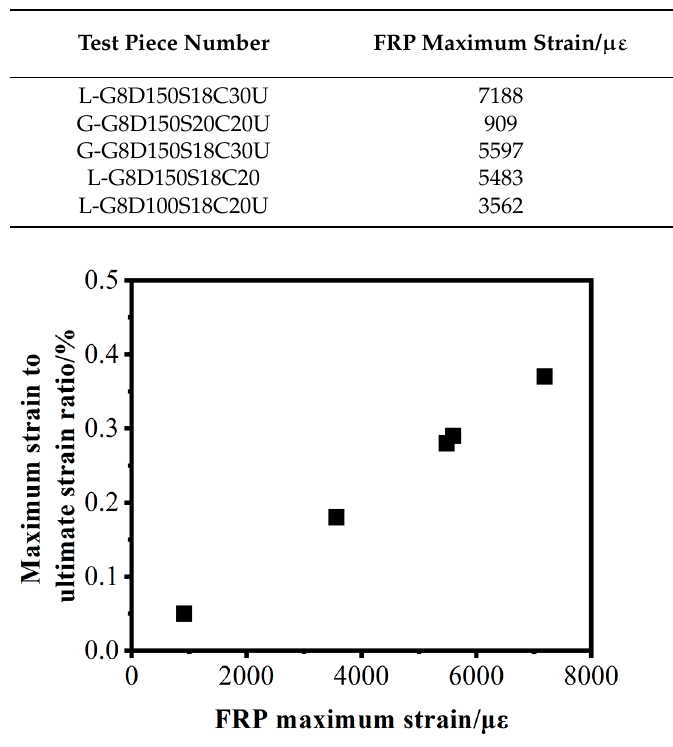
Figure 9. Utilization of GFRP.